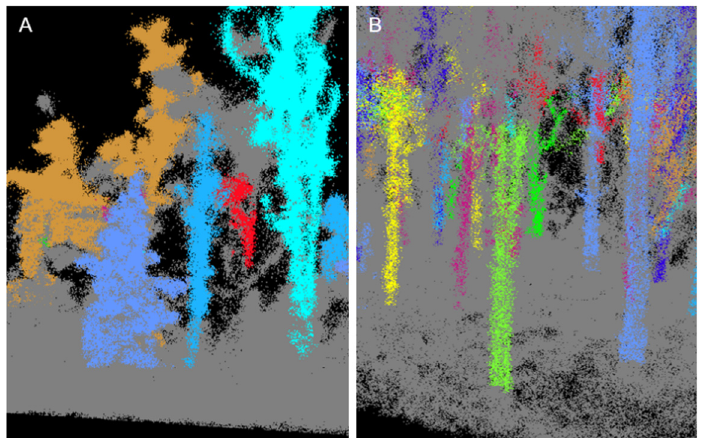
Figure 7. Close-ups of individual trees identified within LiDAR 360 following point cloud segmentation. Specifically, ( A ) illustrates a section where two coniferous trees were identified as a single tree (orange), a single coniferous tree (dark blue) and a single deciduous tree (light blue) were identified appropriately, and a tall shrub (cyan) was identified as a tree; while ( B ) shows an area with multiple deciduous trees identified.